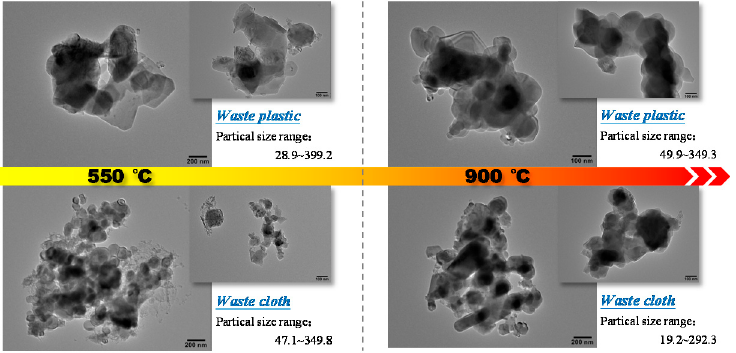
Figure 6. TEM image of ash sample after combustion of the polymeric